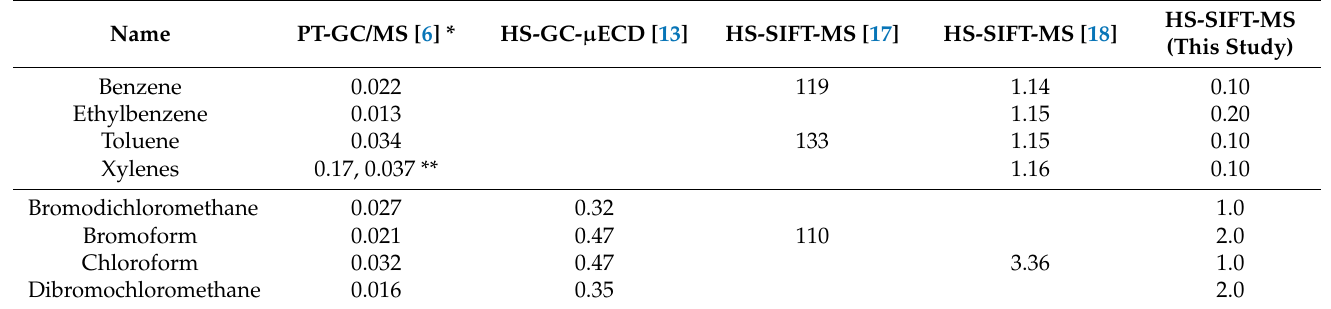
Table 13. Headspace-SIFT-MS LOQs contrasted with a PT-GC/MS method (US EPA Method 524.4 [6]) and HS-GC- µ ECD [13]. All concentrations are µ g L − 1